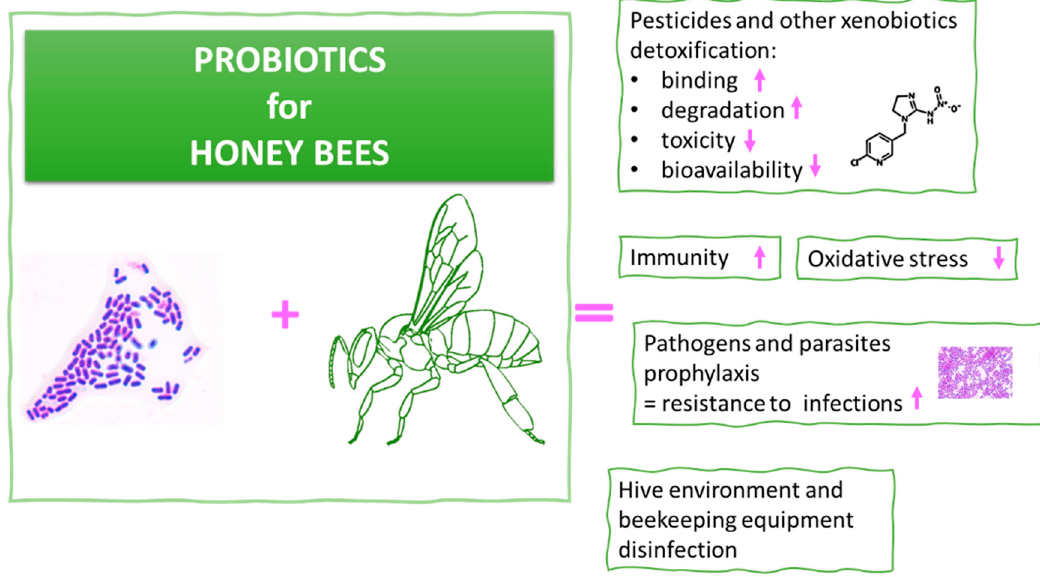
Figure 4. Selected challenges linked to probiotics for honeybees. The figure of the honeybee was taken from http://honey-bee.drawwing.org/book/worker (accessed on 22 March 2021) with the permission of the author.